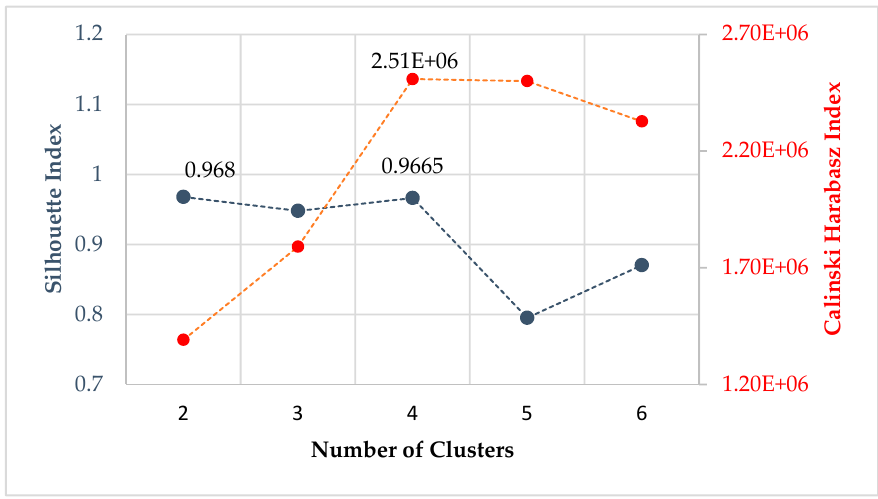
Figure 4. Number of clusters evaluated by the Silhouette index and the Calinski-Harabasz index.